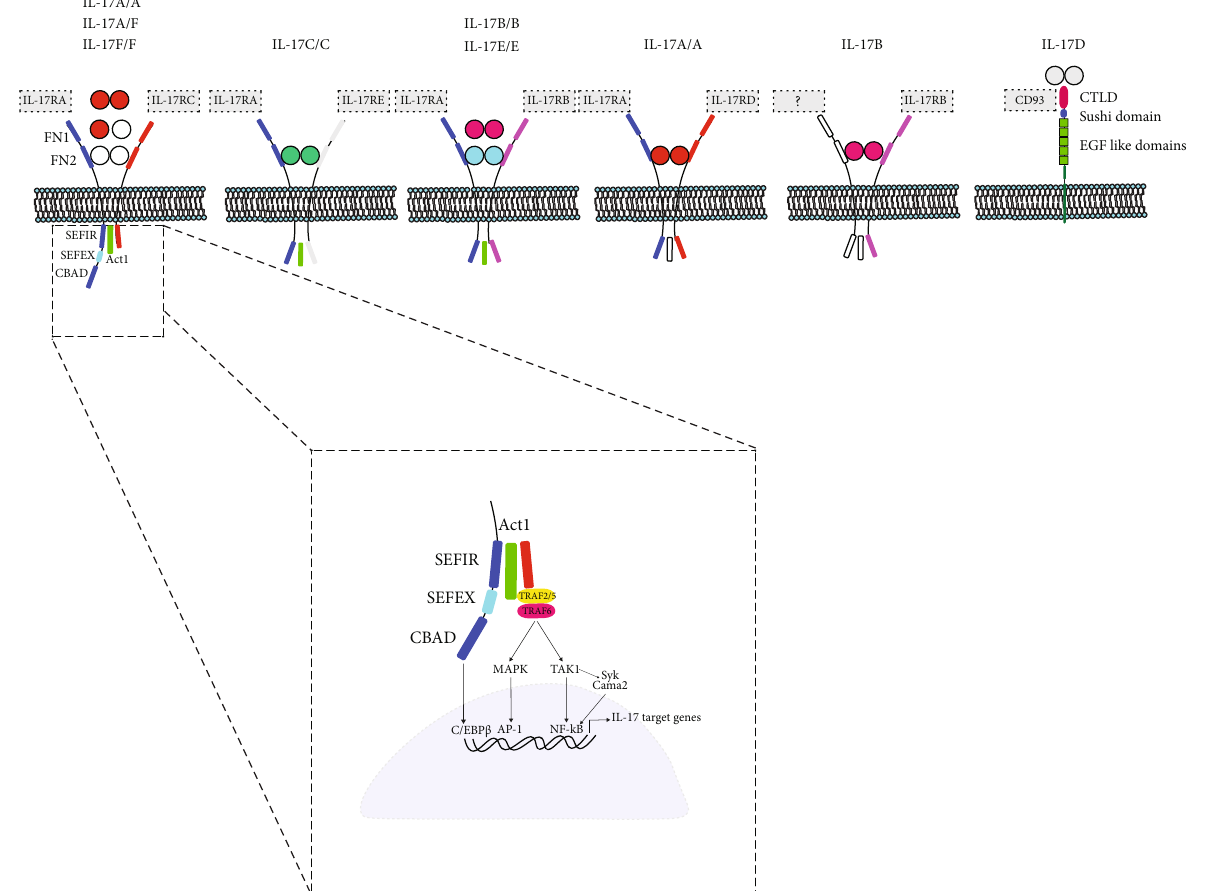
Figure 1: Schematic representation of IL-17 family of cytokines and receptors. IL-17A is the front runner in the IL-17 family of cytokines, comprising six homologues IL-17A to IL-17F in total. The IL-17 receptor family consists of fi ve canonical IL-17 receptors, named IL-17RA to RE; CD93 has recently been identi fi ed as receptor for IL-17D. SEFIR: similar expression of fi broblast growth factor and IL-17Rs; SEFEX: SEFIR extension; CBAD: C/EBP β activation